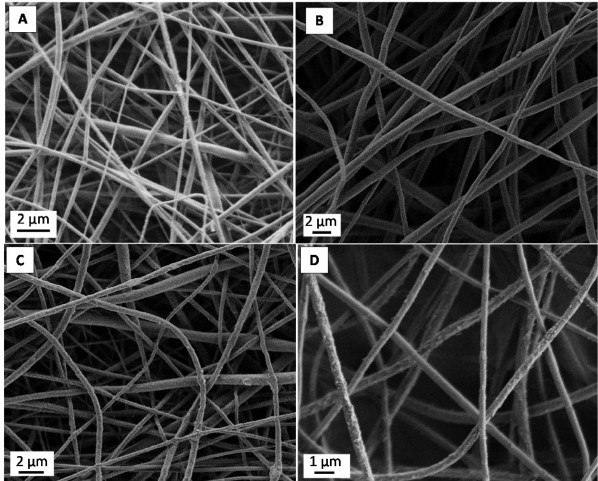
Figure 3. SEM images of PLA/PLA- b -PEG samples containing different amounts of biotin: ( A ) 0 wt %; ( B ) 5 wt %; ( C ) 10 wt % and ( D ) 18 wt